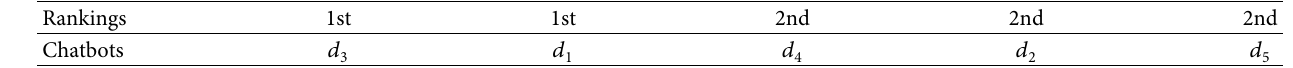
Figure 4: Score, Accuracy & Ranking Comparison for F Table 14: Rankings of chatbots under ( B , ⊟ ) .